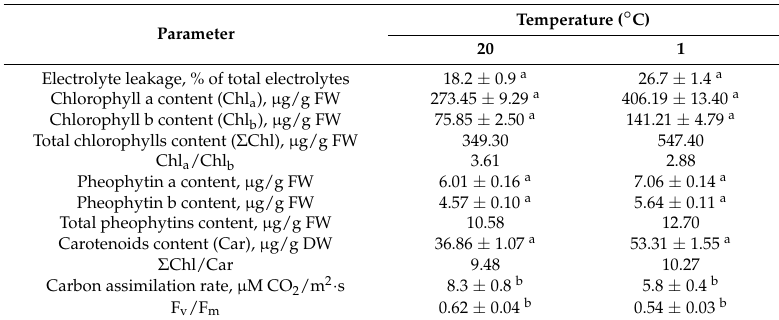
Table 1. Electrolyte leakage (percent of total electrolytes ± SD), photosynthetic pigments content ( µ g/g of fresh leaf weight (FW) ± standard deviation (SD)), carbon assimilation rate ( µ M CO 2 /m 2 · s ± SD) and effective quantum yield of PSII (F v /F m ; ± SD) in D. palmatum leaves cultivated under normal (20 ◦ C) and low (1 ◦ C) temperatures.